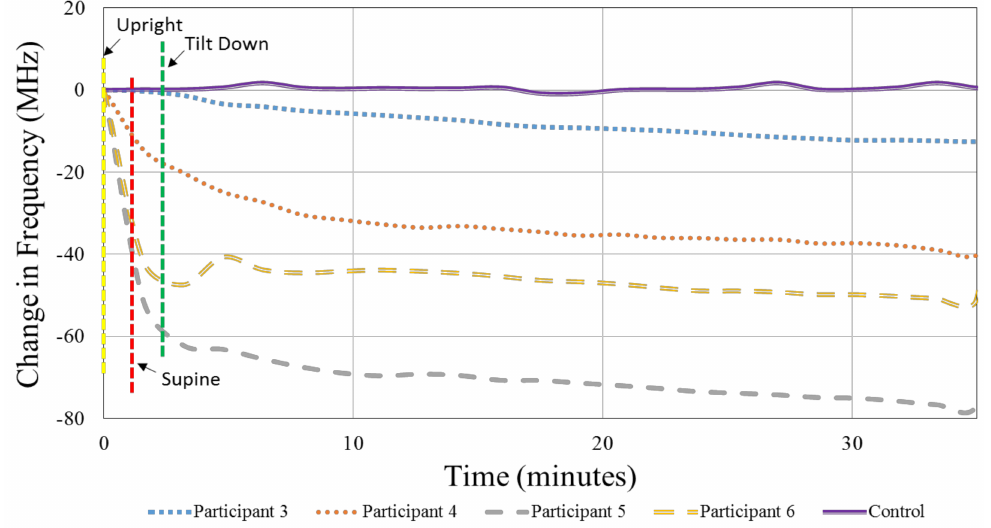
Figure 12. The sensor’s signal response corresponding with a cephalad bio-fluid shift was seen as shifts in the sensor’s principal resonant frequency for the 4 participants and the